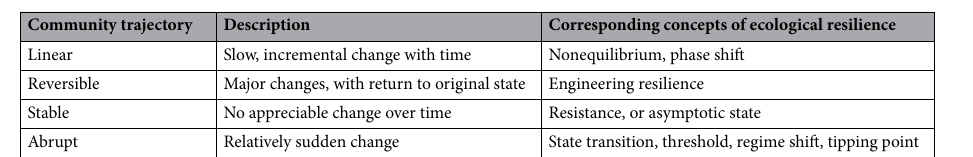
Table 1. Four community trajectories used in this study and their corresponding concepts of ecological resilience as quantitatively identified by Bagchi et al. (2017) 5